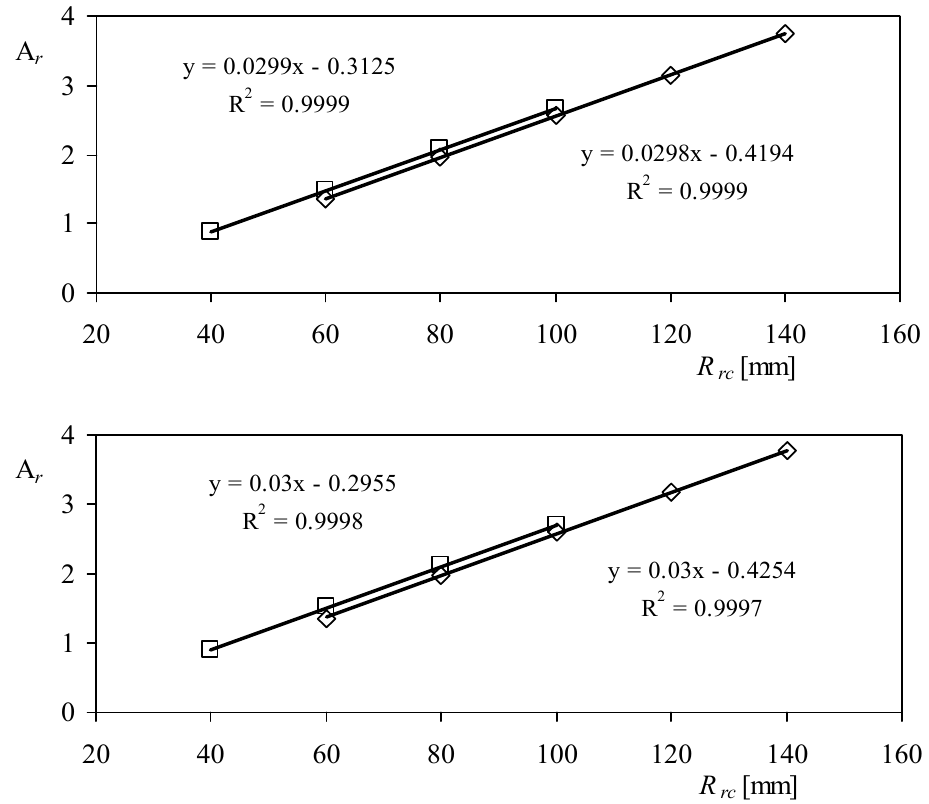
, as a function of the cups’ center rotation radius, Figure 9. Calibration coefficients, A r , for the Climatronics 100075 ( top ) and the Ornytion 107A ( bottom ) anemometers. R rc Anemometers equipped with 50 mm diameter cups (squares), and 80 mm diameter cups (rhombi).